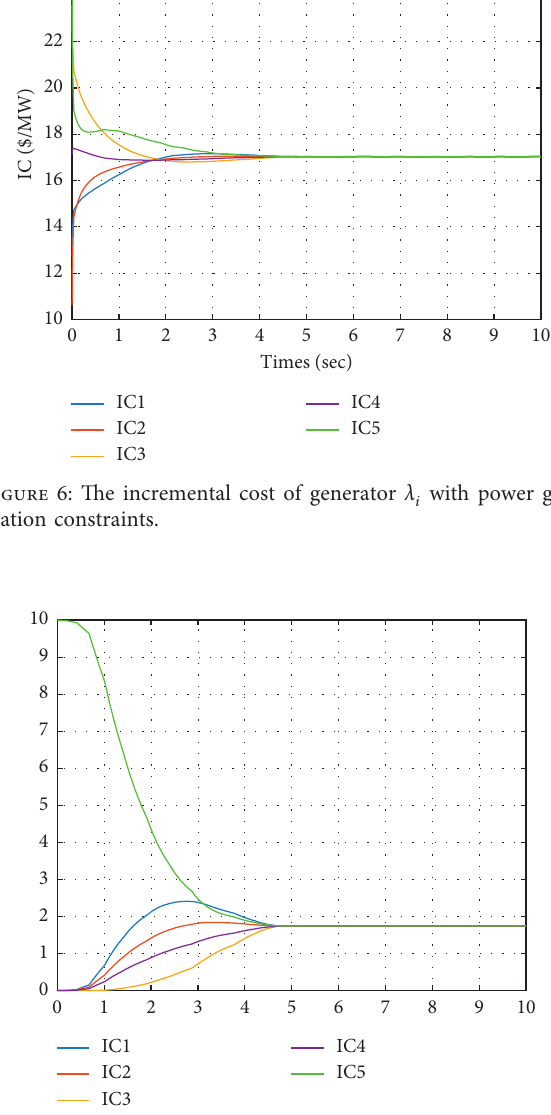
Figure 7: The incremental cost of generator x eration constraints.